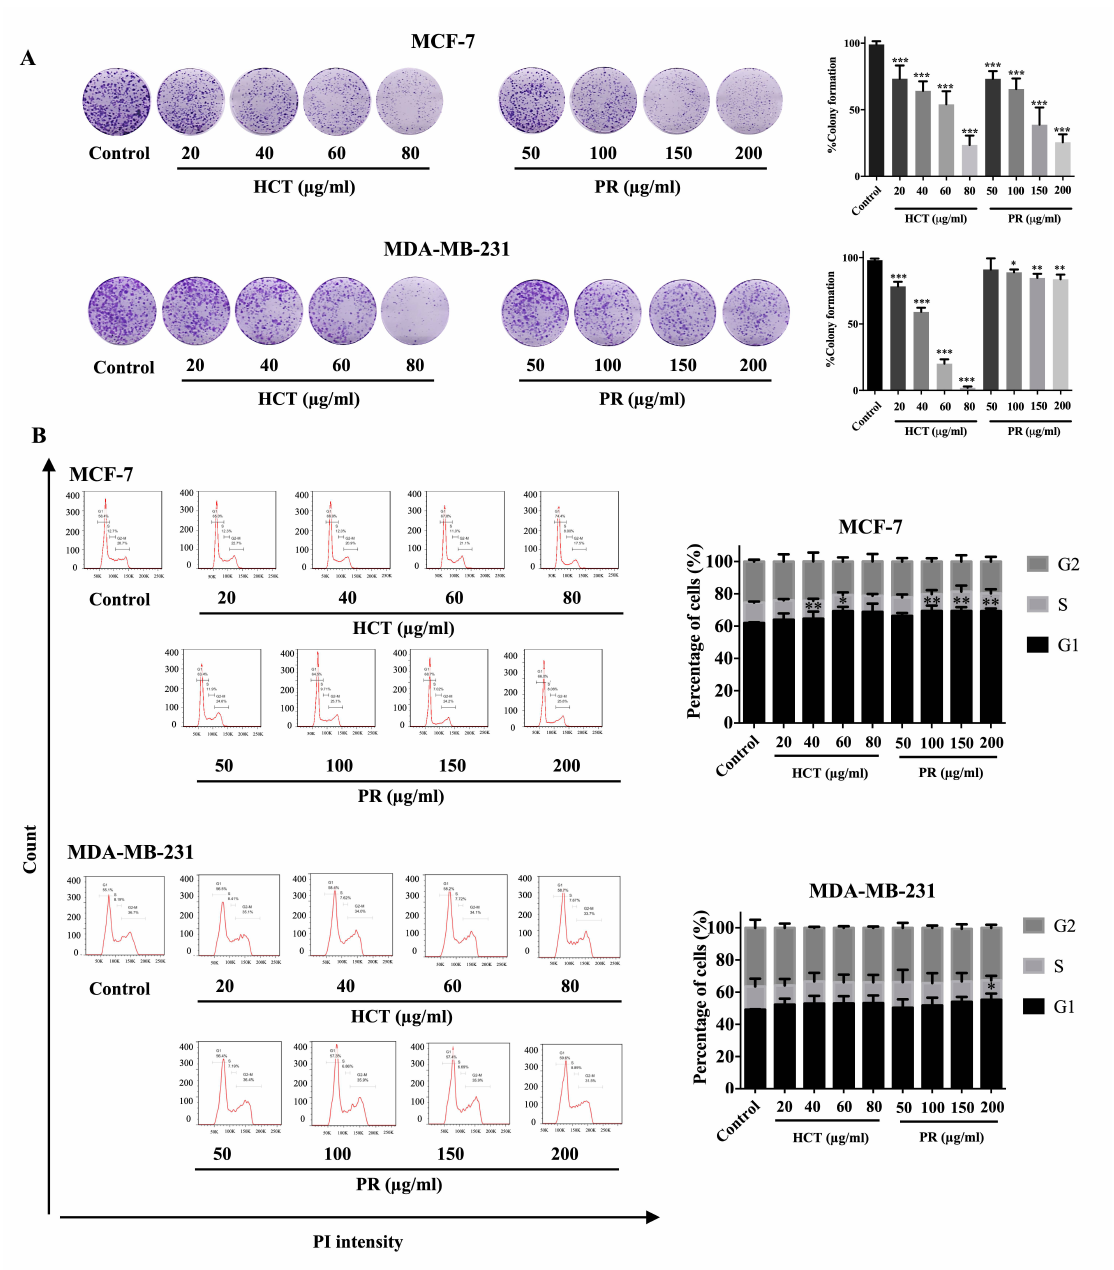
Figure 4. E ff ect of both H. cordata and P. ribesioides extracts on breast cancer cell growth inhibition and cell cycle disruption. ( A ) Colony formation assay. MCF-7 and MDA-MB-231 were treated with non-toxic concentrations of both Houttuynia cordata Thunb. (HCT) and Piper ribesioides Wall. (PR) extracts for 24 h, washed by PBS and cultured for seven days. The colonies were counted and compared with the control. ( B ) For cell cycle assay, the cells were treated with the same condition in the colony formation assay and analyzed by flow cytometry after the cells were stained with propidium iodide. Cell numbers are presented as a percentage of the total analyzed cells. Each value is presented as mean ± SD from three independent experiments. Data are the means ± SD. * p < 0.05, ** p < 0.01, and *** p < 0.001 vs.